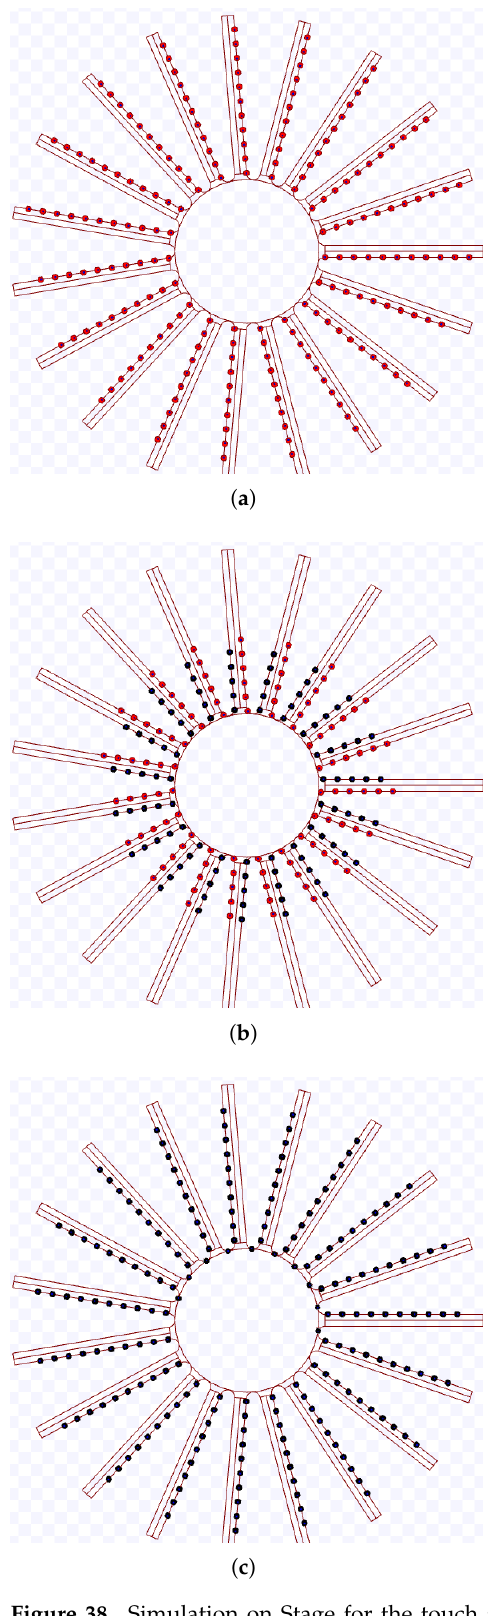
Figure 38. Simulation on Stage for the touch and run strategy using s = 6 m, K = 19 during T = 127.4 s at v = 0.1 m/s. Available on https://youtu.be/xJVoVCIjX5k, accessed on 12 June 2022. ( a ) 0 s: beginning of the simulation; ( b ) After 63.6 s; ( c ) 127.4 s: ending of the